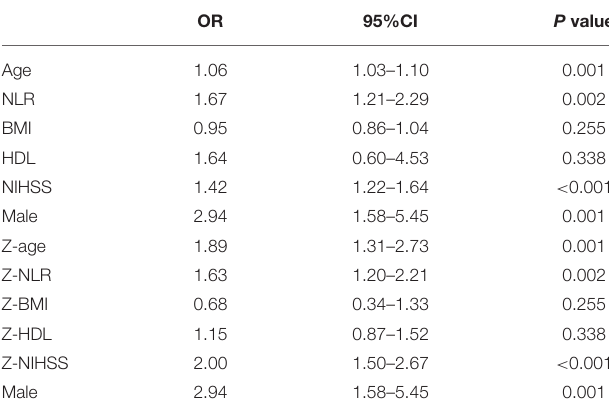
TABLE 2 | Logistic regression analysis of risk factors for suffering from